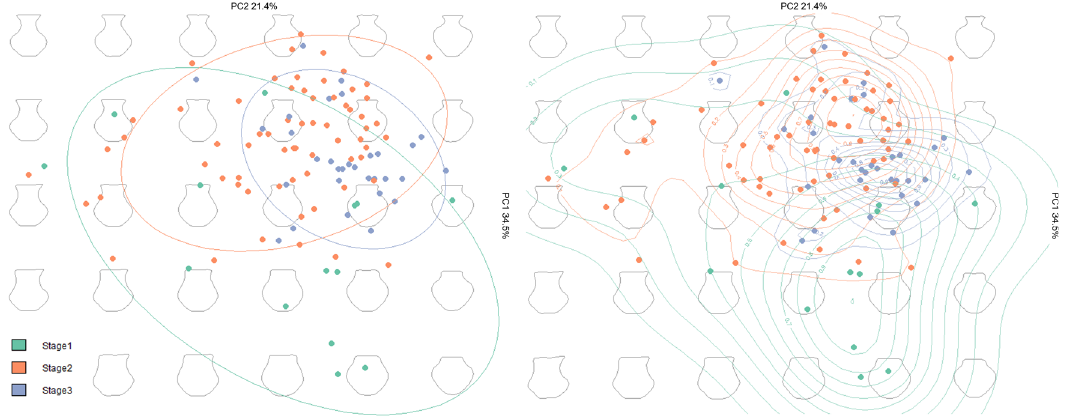
Figure 11: PCA with overlaid morphospace with temporal categories ( stages 1 – 3 ) overlaid in color. Left: 95% con fi dence ellipses overlaid; right: density contours overlaid visualize relative centers, utilizing the ‘ plot_PCA ’